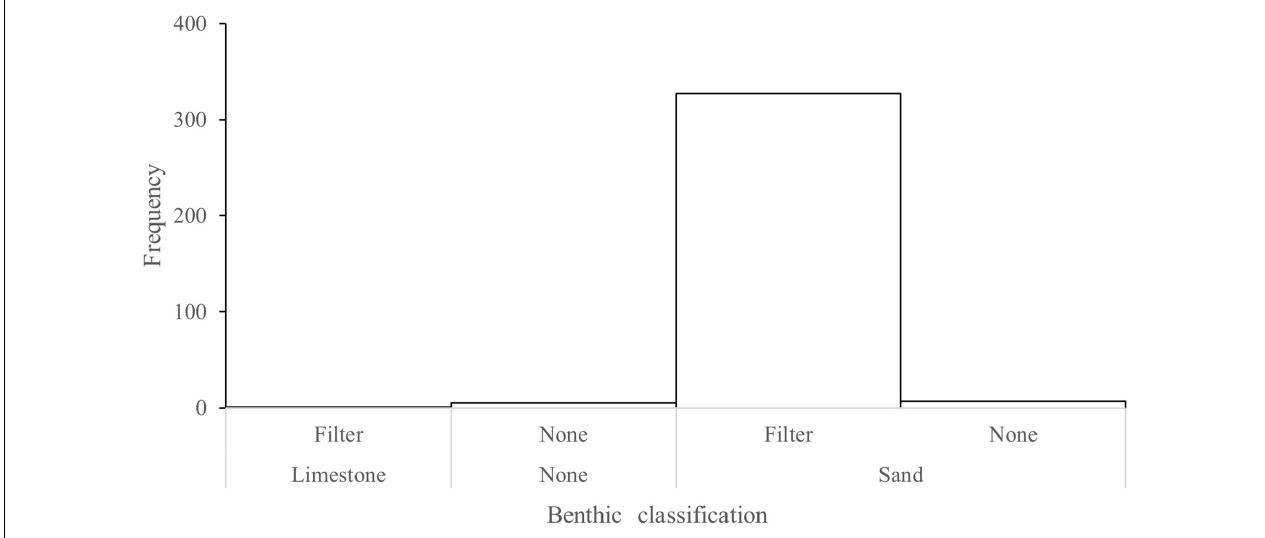
FIGURE 7 | Frequency histogram of taxa and substrate associated with Pinctada maxima towed video observations offshore from Eighty Mile Beach. On the Benthic classification ( X ) axis, the first row of benthic classifications represent epi-benthic organisms where “Filter” is a classification given to any benthic filter feeders including: sponges, gorgonians, and sea whips and “None” representing no organisms observed. The second row represents the substrate composition where “None” represents substrate that could not be